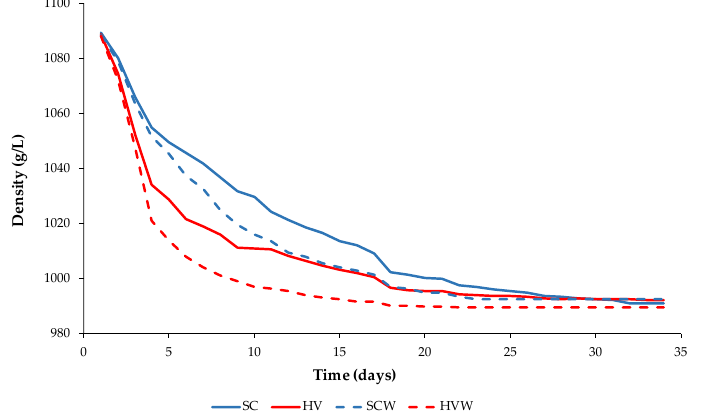
Figure A1. Fermentation kinetics of studied yeast strains. SC (fermentations with S. cerevisiae in stainless steel barrels); HV (fermentations with H. vineae in stainless steel barrels); SCW (fermentations with S. cerevisiae in oak barrels); HVW (fermentations with H. vineae in oak barrels).